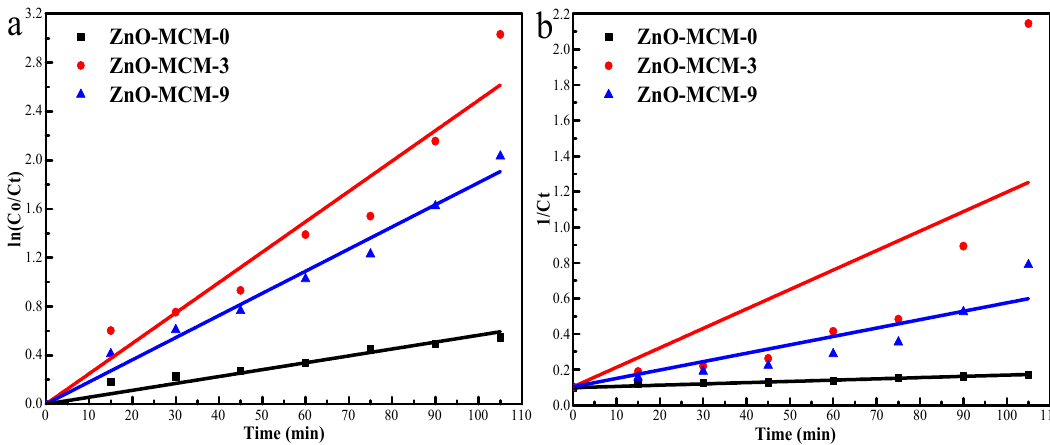
Figure 11. Photodegradation kinetics of MO using the pseudo-first-order model ( a ); and the pseudo-second-order model ( b ). Table 4. Fitting results of the photodegradation of MO.